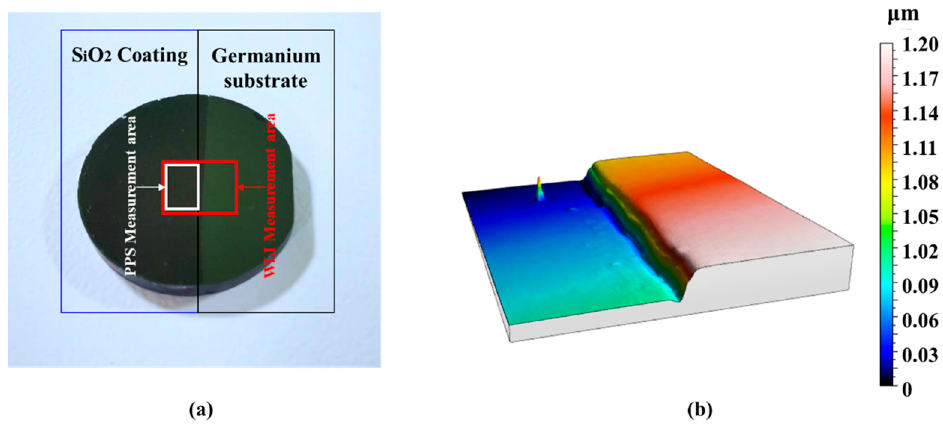
Figure 11. ( a ) The SiO 2 film with a 1 μ m step on the germanium substrate. ( b ) The three dimensional morphology of step by white light interferometry. morphology of step by white light interferometry.